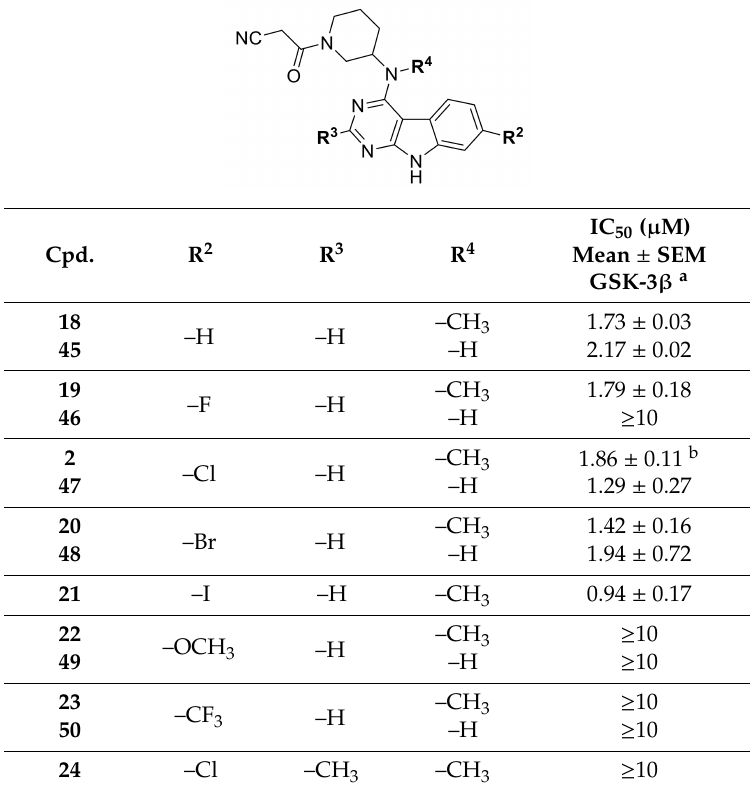
Table 2. Structures and biological activities of compounds 2 , 18 – 24 , and 45 – 50 .